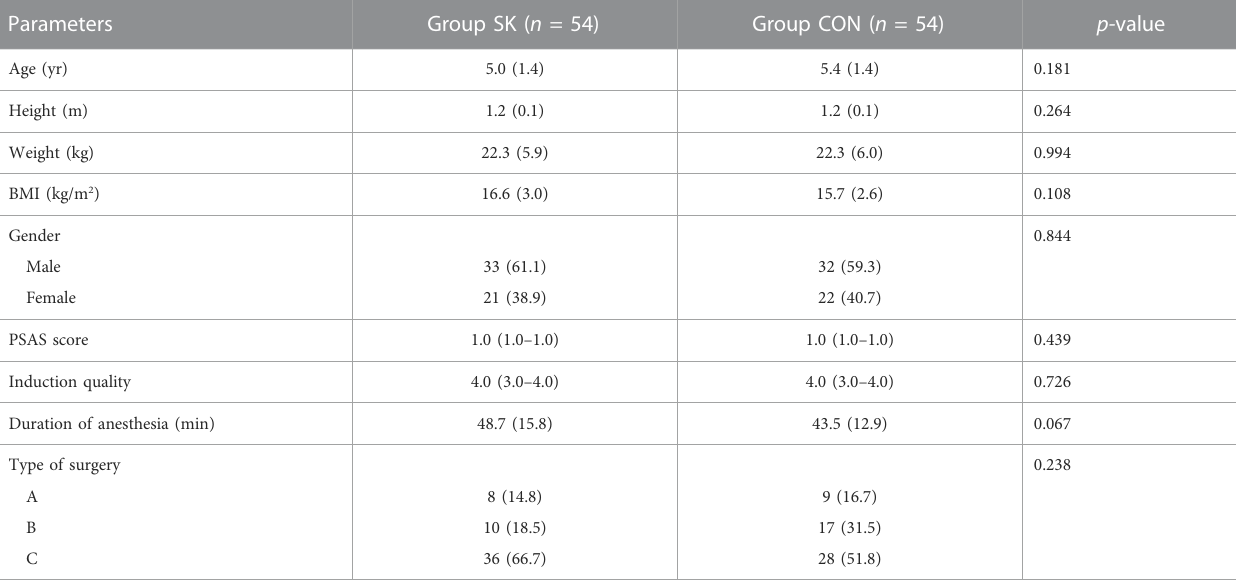
TABLE 3 Patients ’ characteristics and perioperative parameters.